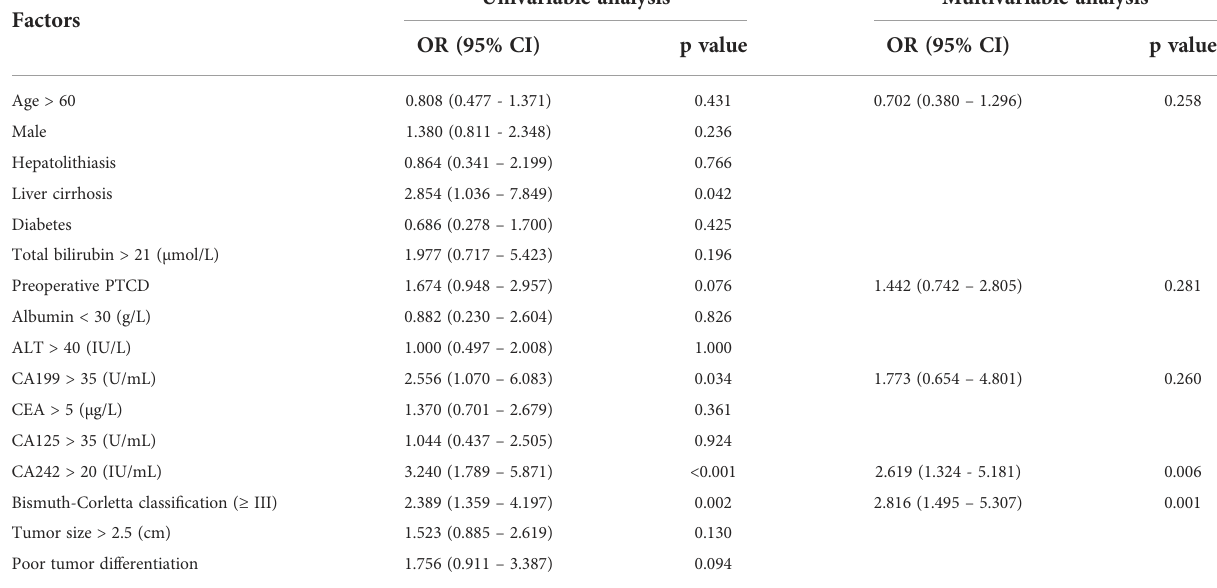
TABLE 2 Univariable and multivariable analysis of risk factors associated with vascular invasion.